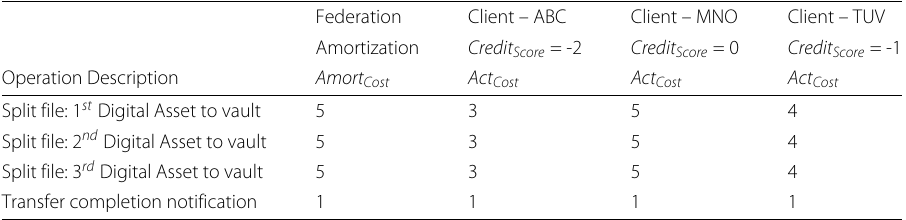
Table 1 Actual cost allocation based on client’s credit score Federation Client – ABC Client – MNO Client – TUV Amortization Credit Score = -2 Credit Score = 0 Credit Score = -1 Operation Description Amort